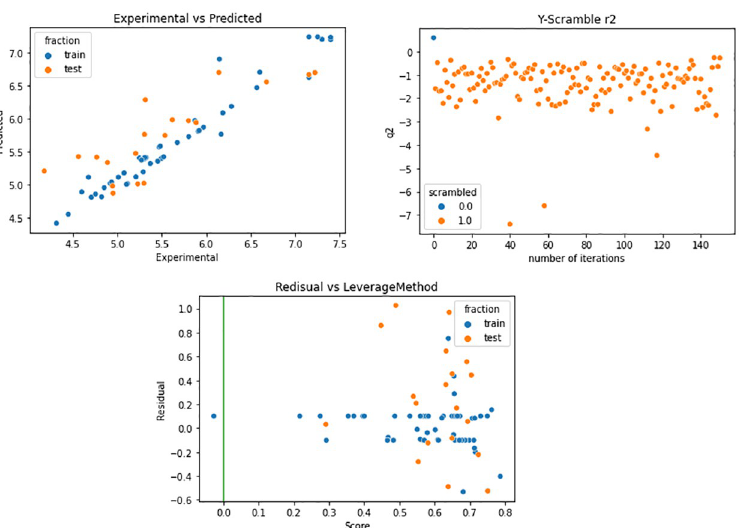
Fig 7. Results of QSAR model. a) Regression plot of the SVR model. The plot shows the predicted values by SVR model against the experimental for the train set (in blue) and test set (in orange). b) Y-Scramble test for the predicted model: In the plot is shown, in orange, the results of the q 2 CV-LMO values for randomized models and in blue the q 2 CV-LMO values for the true model (no randomized). c) Williams plot for the calculated model: The Applicability Domain was calculated by the leverage method.